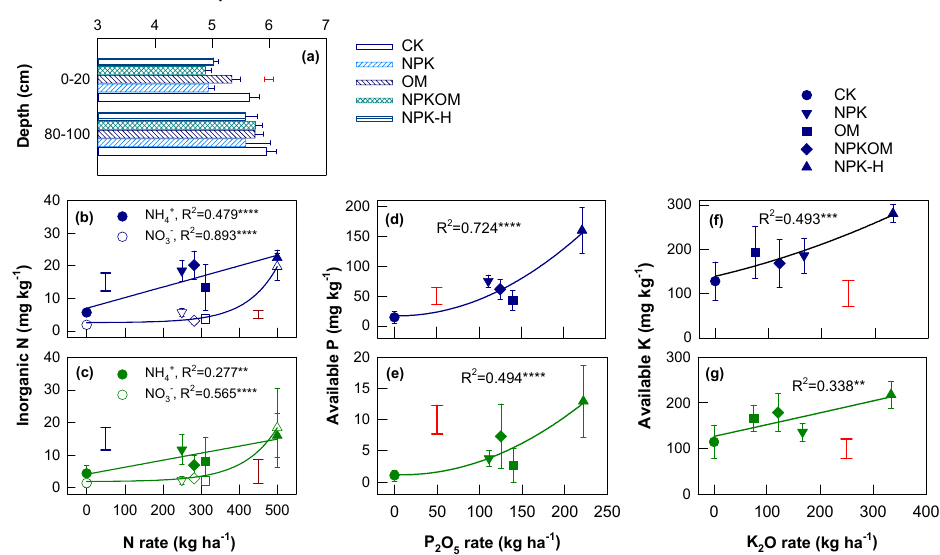
Figure 6. Soil pH ( a ), contents of NO 3- − N ( b , c , open symbols), NH 4+ − N ( b , c , closed symbols), available P ( d , e ), and K ( f , g ) in the soil of 0–20 cm ( b , d , f ; in blue) and 80–100 cm ( c , e , g ; in green) depths. Single bars without data are LSD values indicative of significant difference among treatments. Regression lines are indicated with R 2 values and significance levels (*, p < 0.05; **, p < 0.01; ***, p < 0.001; ****, p < 0.0001).